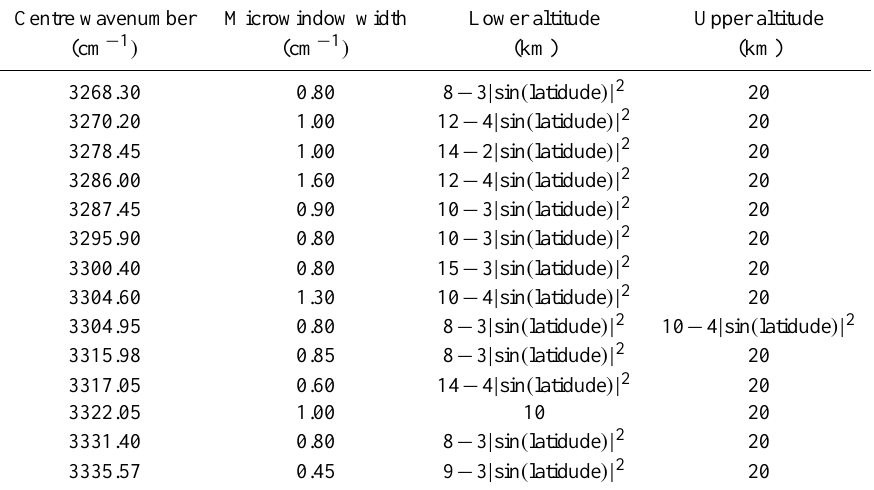
Table 1. Microwindows used for the retrieval of C 2 H 2 in this